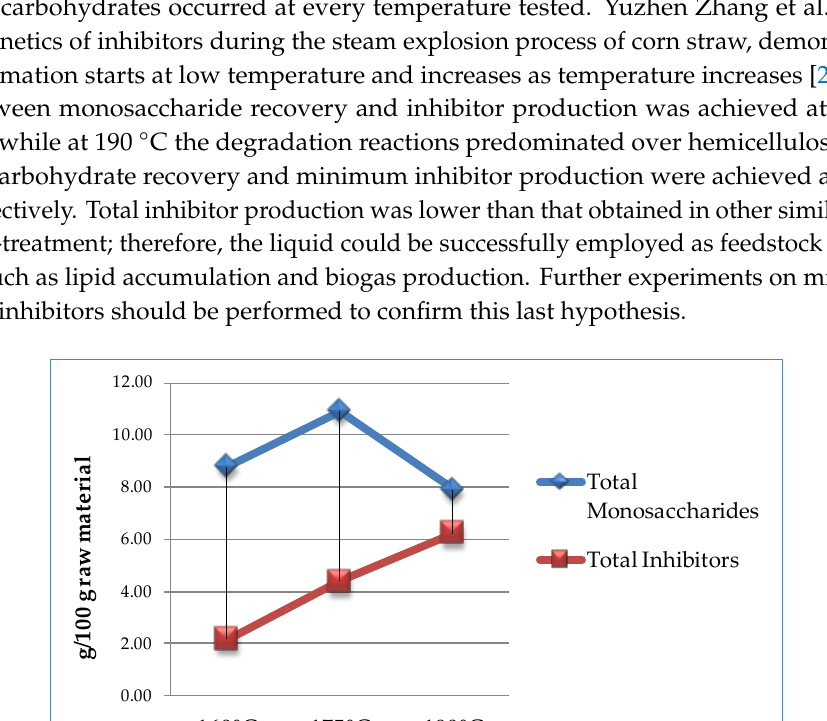
Figure 2. Mono- and oligosaccharides of cellulose and hemicellulose recovered in the LF.